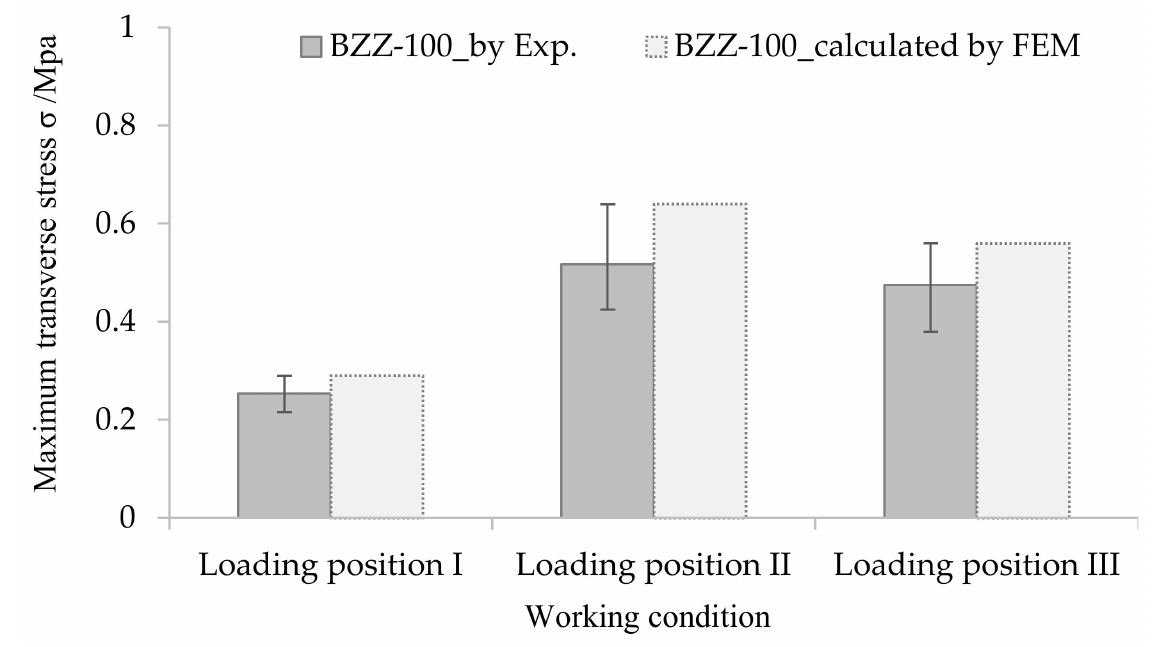
Figure 8. Comparison between the measured and simulated results of the transverse maximum tensile stress of asphalt pavement on the steel bridge deck under the action of BZZ-100 axle